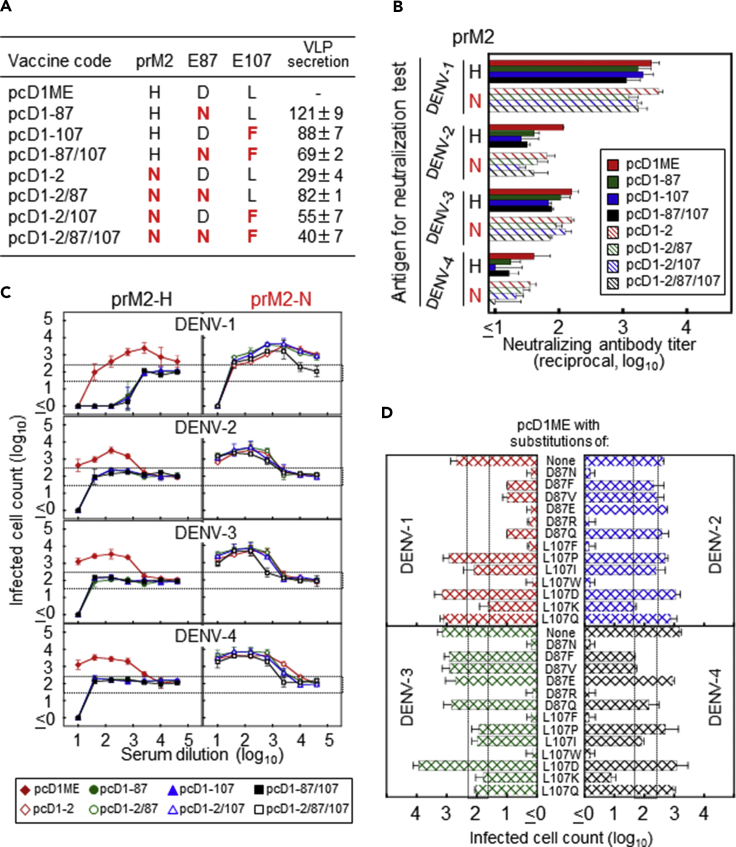
Assessment of EAb Induction Using a DENV-1 Mochizuki-Mouse Model(A) Mutation sites (indicated in red) included in pcD1ME variants. Three amino acids at positions prM2, E87, and E107 were targeted for substitution. The VLP secretion levels of these pcD1ME variants are expressed as relative optical density values (%) compared with that obtained using the original pcD1ME.(B and C) NAb titers (B) and enhancing activities (C) induced in immunized mice. (B) PRNT75 (75% plaque-reduction neutralizing test) antibody titers were obtained from two independent experiments. The x axis shows the serum dilutions corresponding to the PRNT75 value. (C) Enhancing activities were obtained from two independent experiments. The x axis shows the serum dilution, and the y axis displays the infected cell counts (in log10). Dotted lines (lower/higher) indicate the cutoff values used to differentiate neutralizing or enhancing activities from non-neutralizing or non-enhancing activities, respectively.(D) Enhancing activities induced by pcD1ME designed to express E containing various single amino acid substitutions at positions 87 or 107. Groups of three mice were used for experiments shown in (D). Enhancing activities are shown as dose-dependent enhancing activity curves in (C) but are shown as values obtained at 1:160 against DENV-1 or 1:10 against DENV-2–DENV-4 in (D). Labels in panels indicate serotypes of assay antigens. Dotted lines indicate the cutoff differentiating neutralizing or enhancing from non-neutralizing or non-enhancing activities. Data represent averages of two independent assays ± SD.See also Figures S1 and S2.